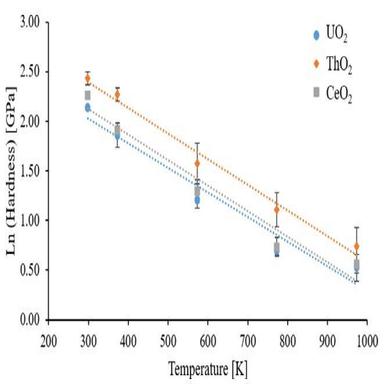
The ln(Hardness) versus temperature for the three fluorite crystal structure materials.